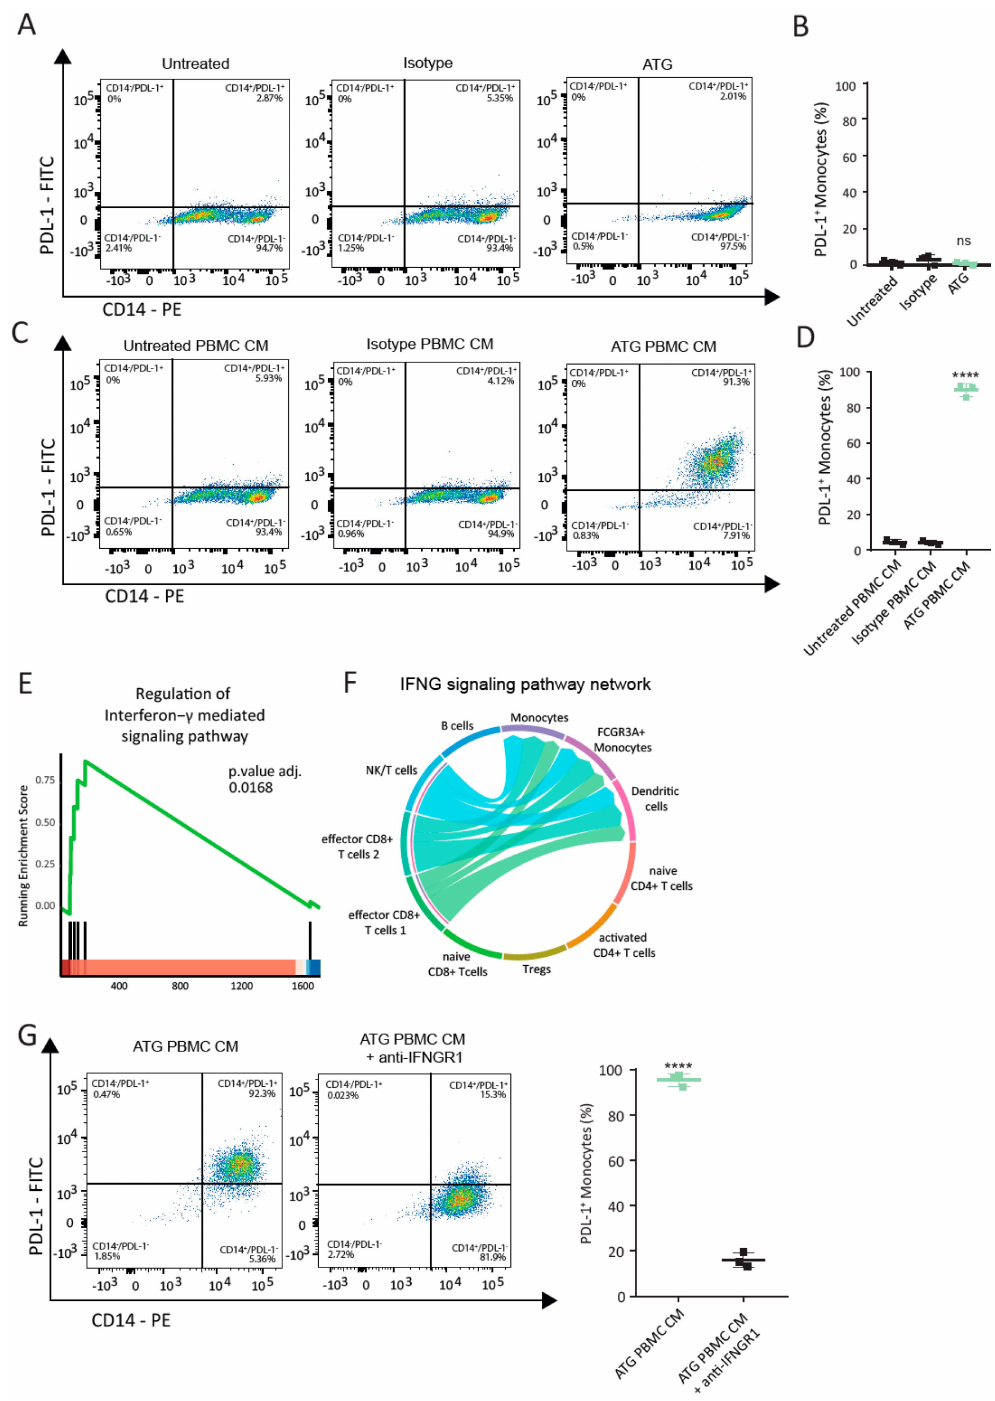
plot showing the mean percentage of monocytes expressing CD274 and standard error of the mean (SEM) in Untreated, Isotype and ATG. N = 2 donors. ( C ) Flow cytometry analysis for surface expression of PDL-1 on monocytes from whole blood and purified PBMCs after treatment with ATG. Histogram displaying percentage of PDL-1 + monocytes in Untreated (black), Isotype (grey) and ATG (green) from whole blood and purified PBMCs. **** indicates p -value < 0.0001.